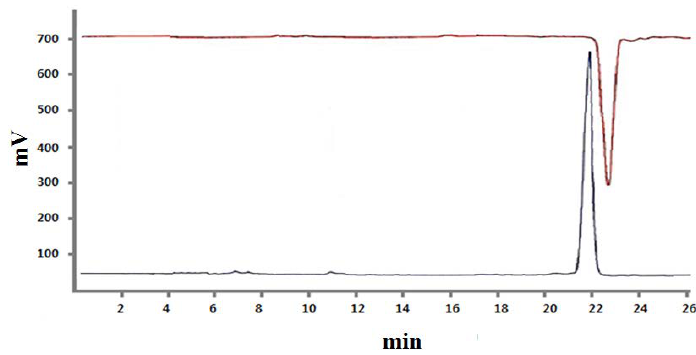
Figure 2. HPLC chromatograms of 99m Tc-CB256 ( 1 , red) and Re-CB256 ( 2 , black). Xterra RP-18; 20%–90% acetonitrile-water; flow rate 3 mL/min.